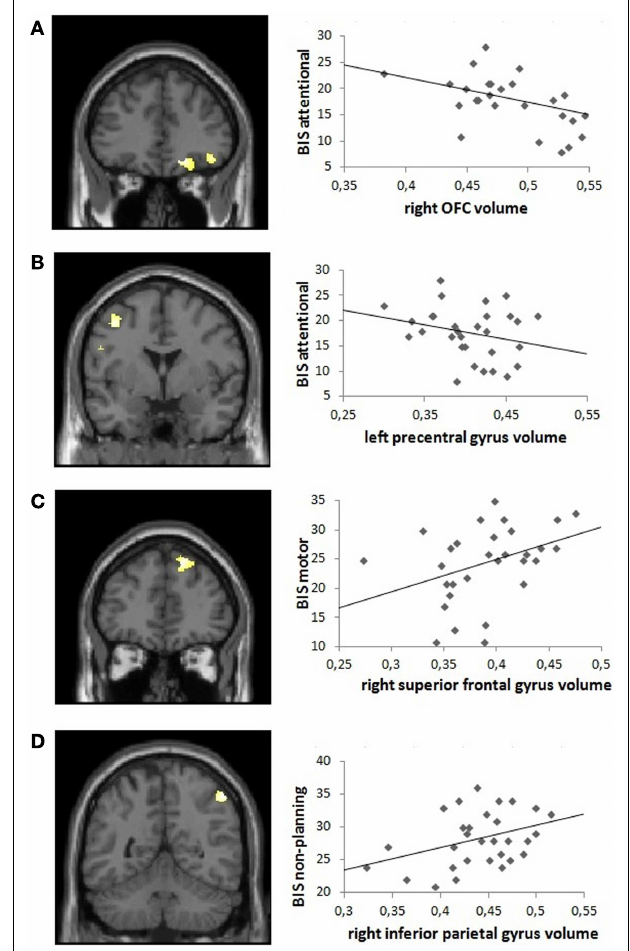
FIGURE 2 |Visual representation of the correlation between Barratt Impulsivity Scale (BIS) subscores and frontal gray matter volume in non-treatment-seeking cocaine-dependent individuals: positive correlations are shown between (A) BIS attentional impulsivity and right orbitofrontal cortex volume and (B) BIS attentional impulsivity and left precentral gyrus volume, and negative correlations between (C) BIS motor impulsivity and right superior frontal gyrus volume and (D) BIS non-planning impulsivity and right inferior parietal gyrus volume, derived from the model including both BDI and FTND covariates . Left panels: coronal sections illustrating the significant clusters ( p < 0.05 corrected, at a height threshold of p < 0.001, uncorrected). Right panels: scatter plots illustrating the correlations in the anatomically defined regions of